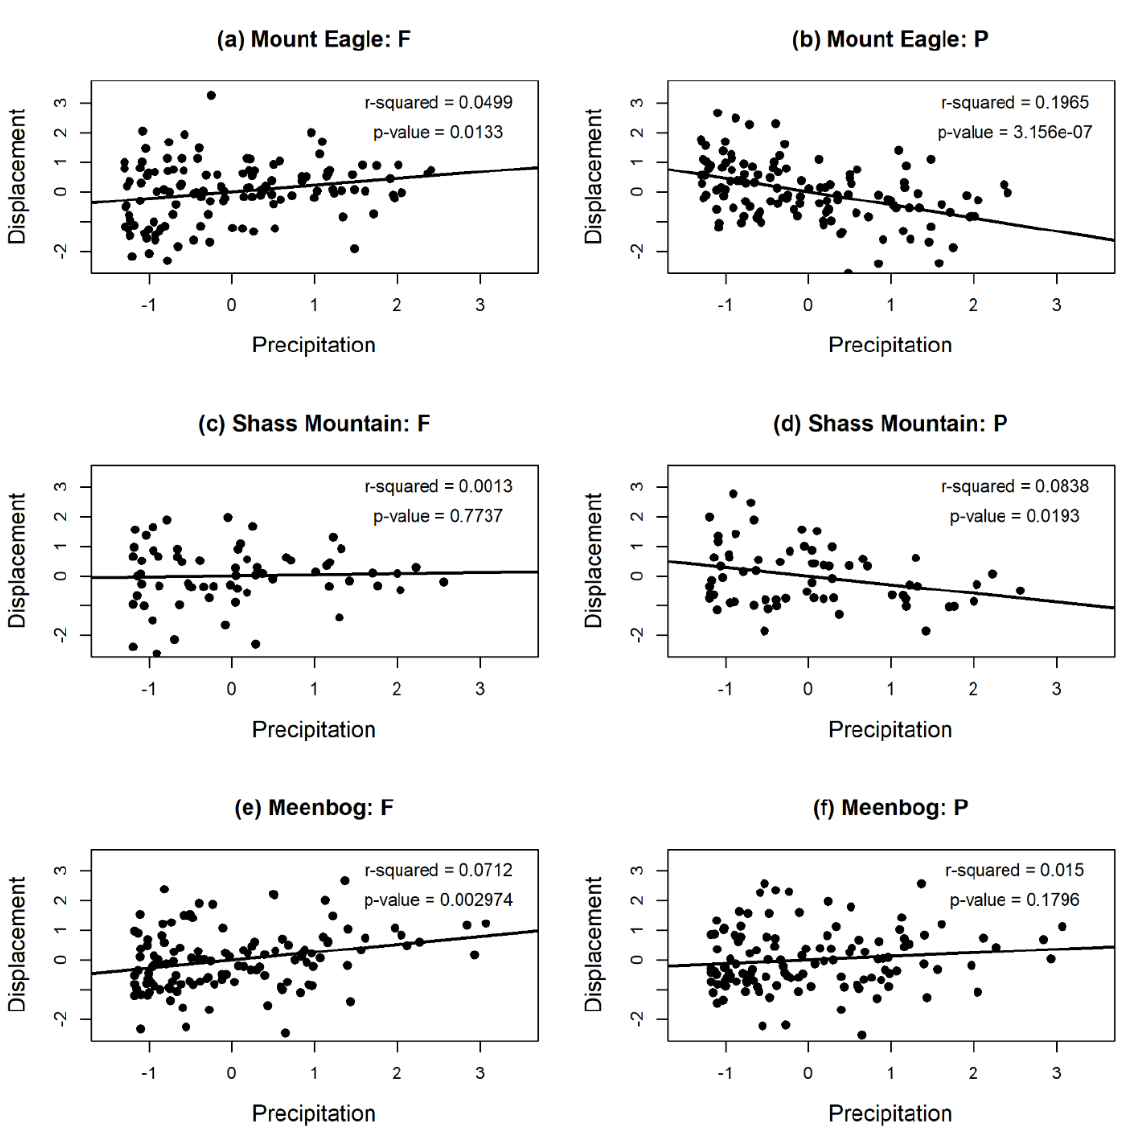
Figure 6. Scatter plots of normalised precipitation and vertical surface motion (MSSA data) time series within the peat slide (F) and on nearby blanket bog (P) (see Figure 2), for the Mount Eagle (a–b), Shass Mountain (c–d) and Meenbog slides (e–f). Linear-regression is shown with r-squared and